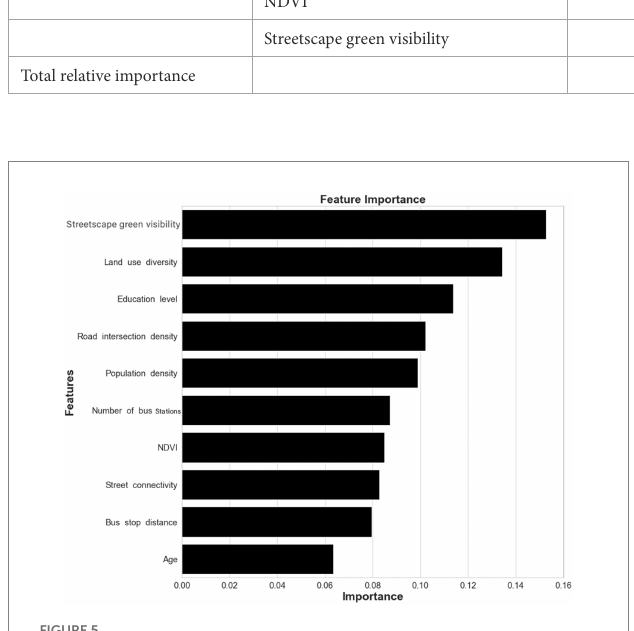
FIGURE 5 Predictor variables’ relative